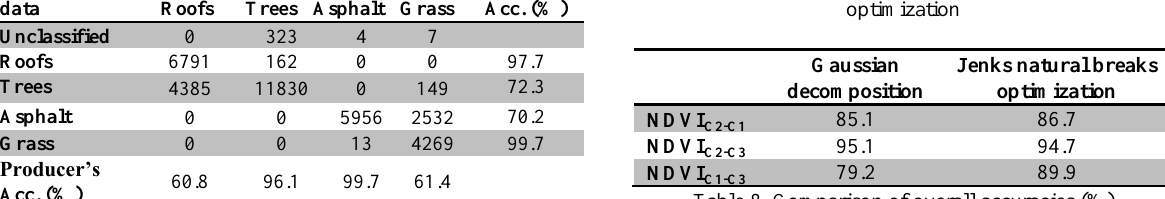
Table 5. Confusion matrix based on NDVI C2-C3 Classification